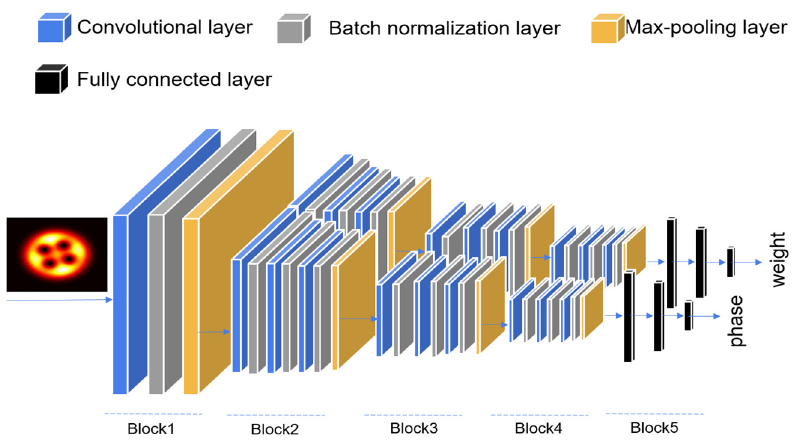
Figure 2. Illustration of dual output CNN.